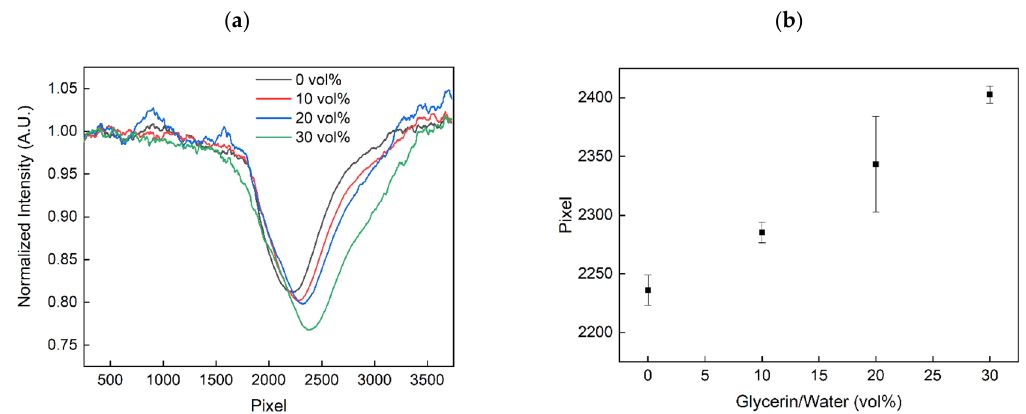
Figure 4. Measured sensor spectrum ( a ) and the resulting shift of the SPR ( b ) for increasing glycerin volume concentrations and thus for increasing refractive indices.